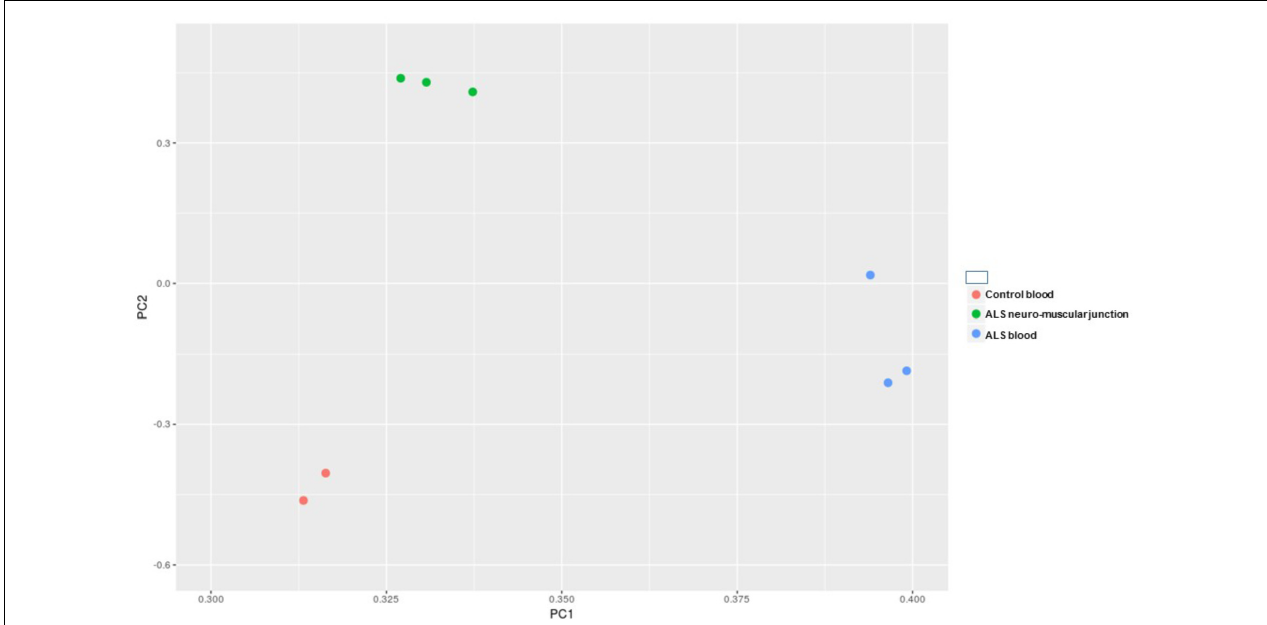
FIGURE 1 | Principal component analysis (PCA) of all of the samples underwent to small RNA-Seq analysis.